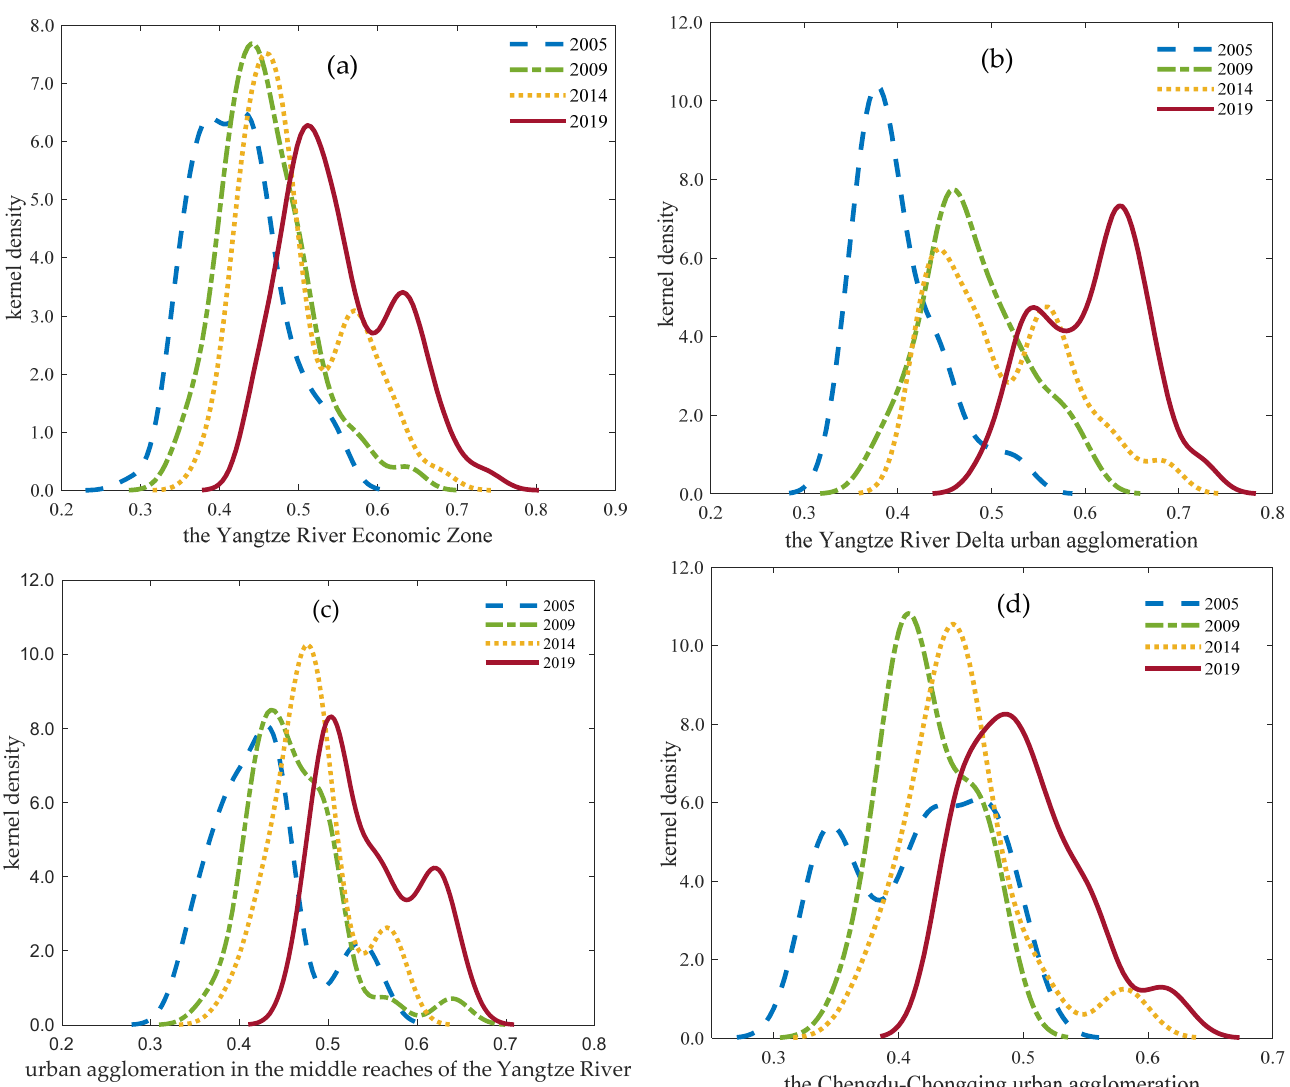
Figure 5. Temporal evolution of coupling coordination degree between industrial integration and ULUE. ( a ) The Yangtze River Economic Zone; ( b ) the Yangtze River Delta urban agglomeration; ( c ) urban agglomeration in the middle reaches of the Yangtze River; ( d ) the Chengdu–Chongqing urban agglomeration.